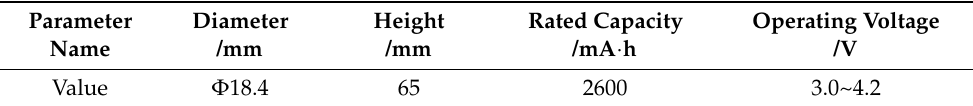
Table 1. Parameters of the battery.